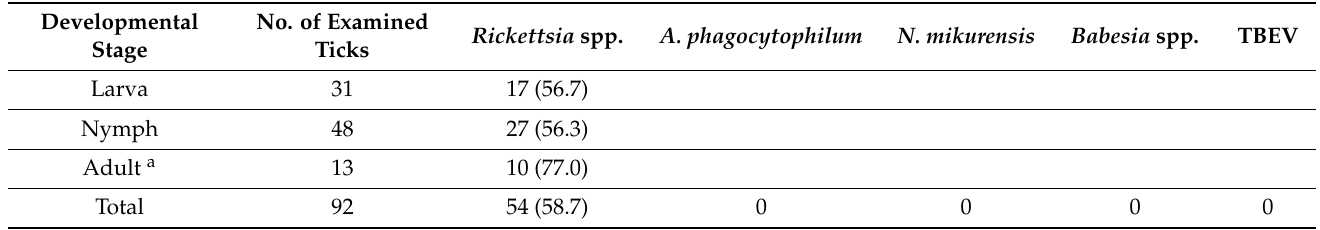
Table 3. Tick-borne microorganisms detected in Carios vespertilionis ticks from the province of Uppland, in 2015 and 2018, and from the province of Småland, in